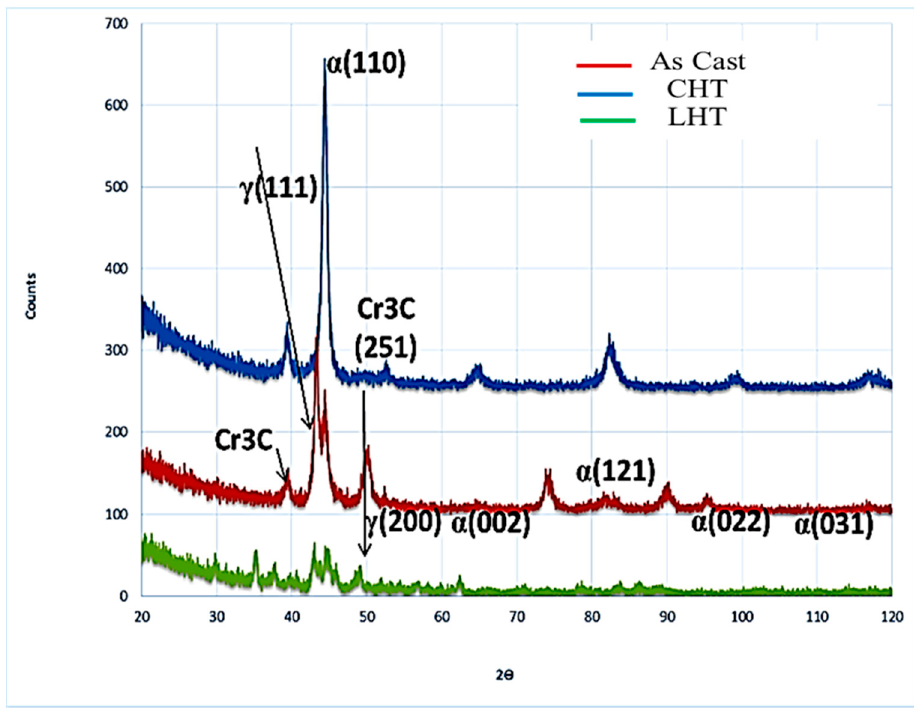
Figure 7. XRD Pattern of the S1 (Ni-hard 1) as-cast, conventionally heat-treated and laser-treated samples.